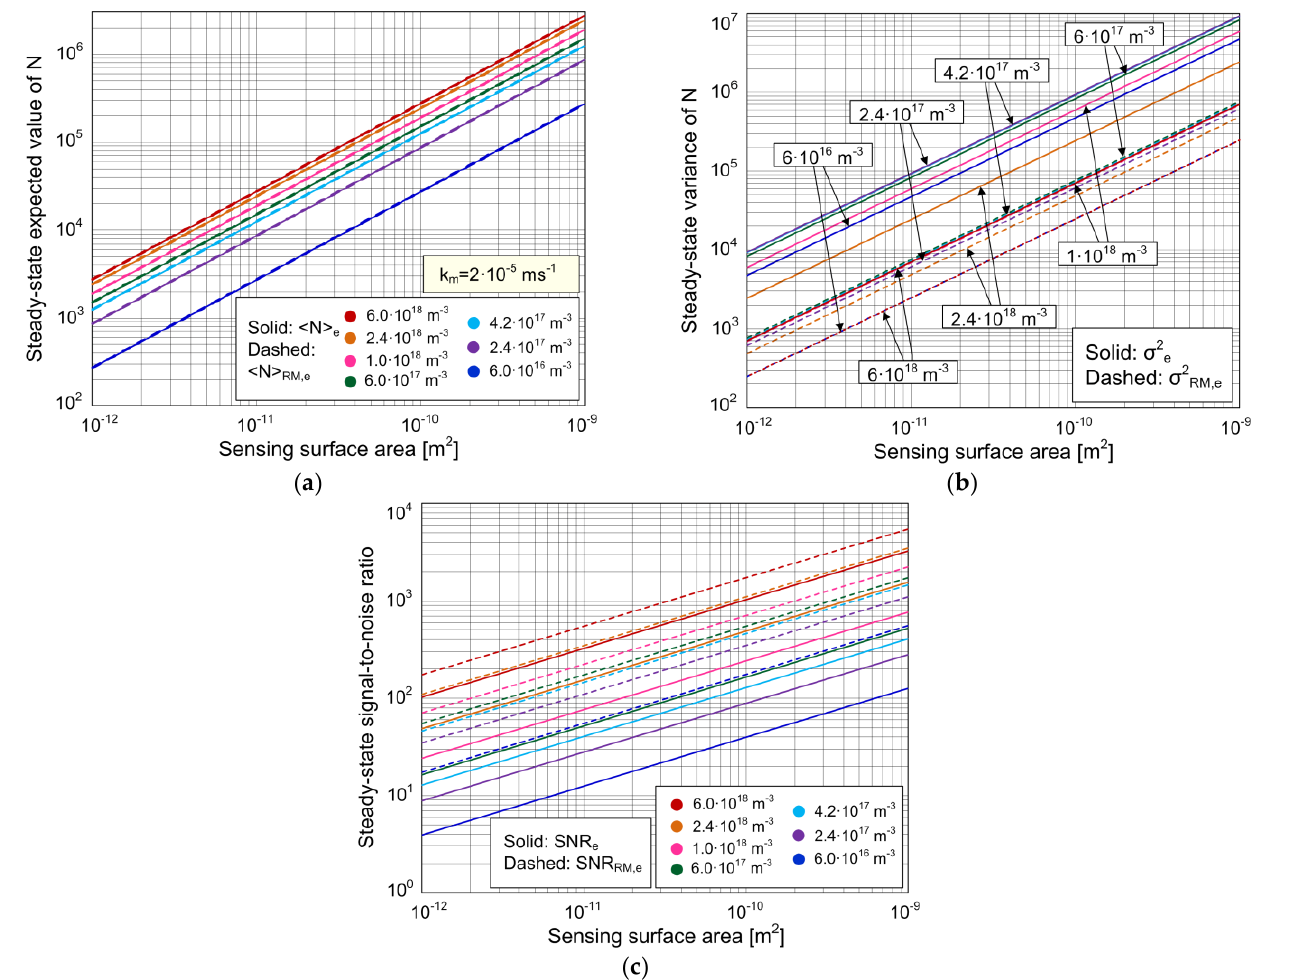
Figure 5. Expected value ( a ) and variance ( b ) of the number of adsorbed particles in the steady state, and the steady-state signal-to-noise ratio ( c ), as a function of the sensing surface area, for different concentrations of the target protein, according to the stochastic model that takes into account the combined effect of AD and mass transfer processes (solid lines), and according to the stochastic model that neglects mass transfer (dashed lines).